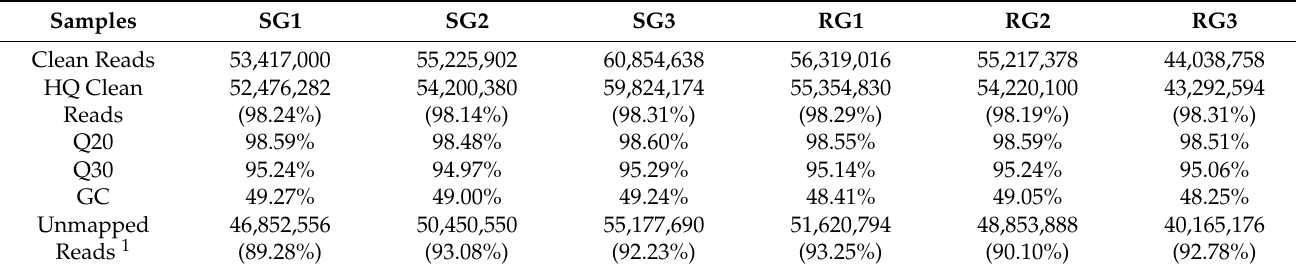
Table 2. RNA-seq data.